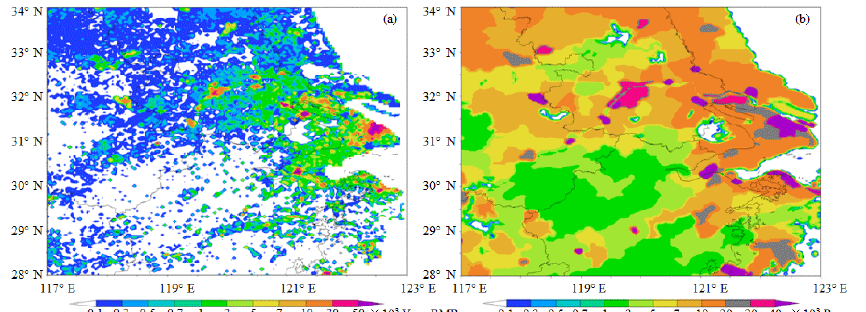
Figure 1. Spatial distribution of gross domestic product (a) and population (b) in 2010 over the region between (117 ◦ E, 28 ◦ N) and (123 ◦ E, 34 ◦ N) with the resolution of